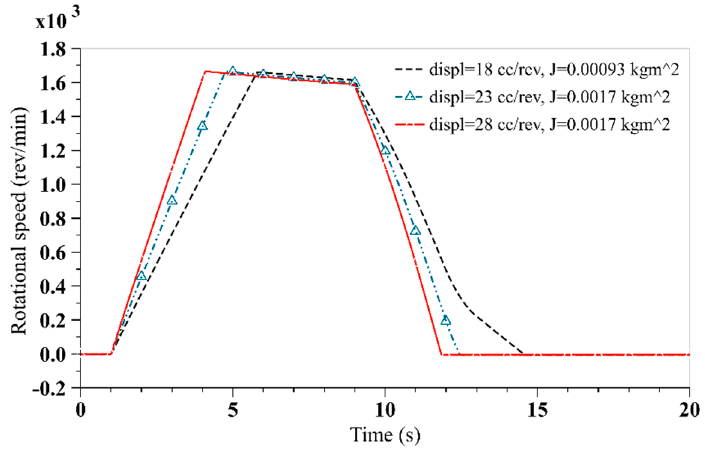
Figure 22. Rotational speeds of the flywheel at different PM displacements.